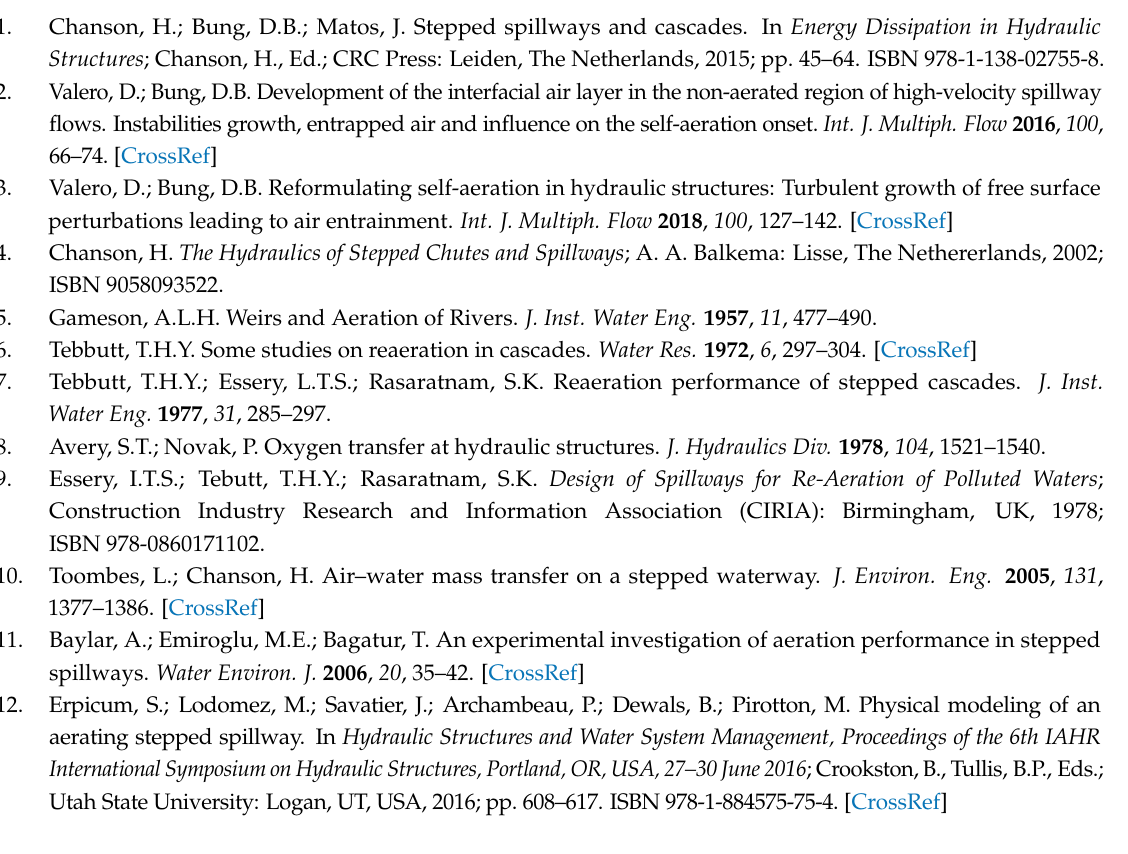
Figure A2. Numerical integration of the waved interfacial surface for a squared Being the